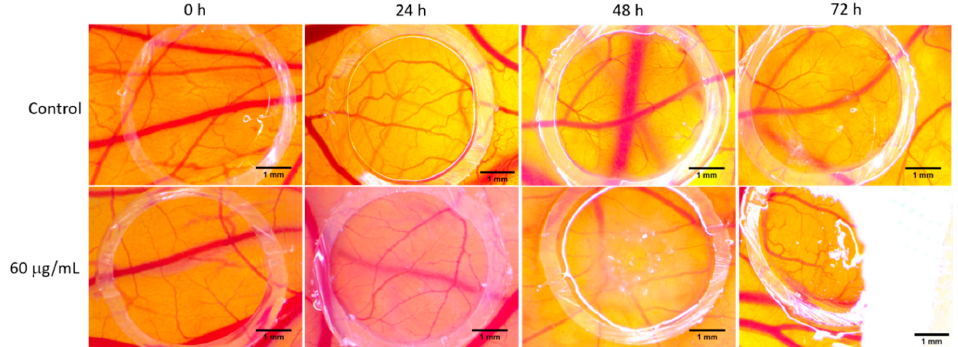
Figure 7. Normal angiogenesis evaluation in chorioallantoic membrane (CAM) assay. The OB extract (60 µg/mL) was applied next to the dimethyl sulfoxide (DMSO) as the control; stereomicroscope photographs were recorded at 0 h, 24 h, 48 h and 72 h. CAM, chorioallantoic membrane; OB, Oenothera biennis ; DMSO, dimethyl sulfoxide.